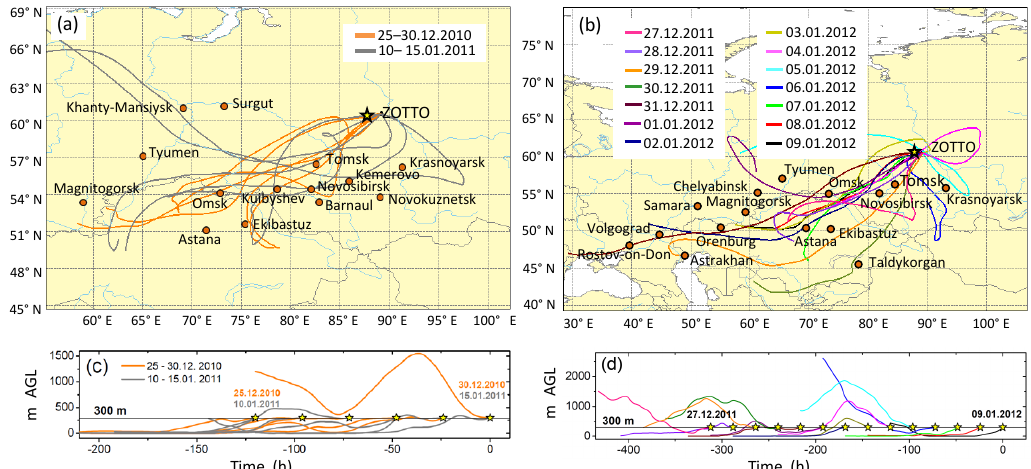
Figure 6. Figure shows 120h HYSPLIT backward air mass trajectories with 24h intervals during winter pollution events at ZOTTO at 300m observed from 25 to 30 December 2010 ( a , orange), 10 to 15 January 2011 ( a , grey), and 27 December 2011 to 9 January 2012 ( b ) and trajectory height above ground level (a.g.l.) (c, d) . Stars and dates show the arrival time of the air